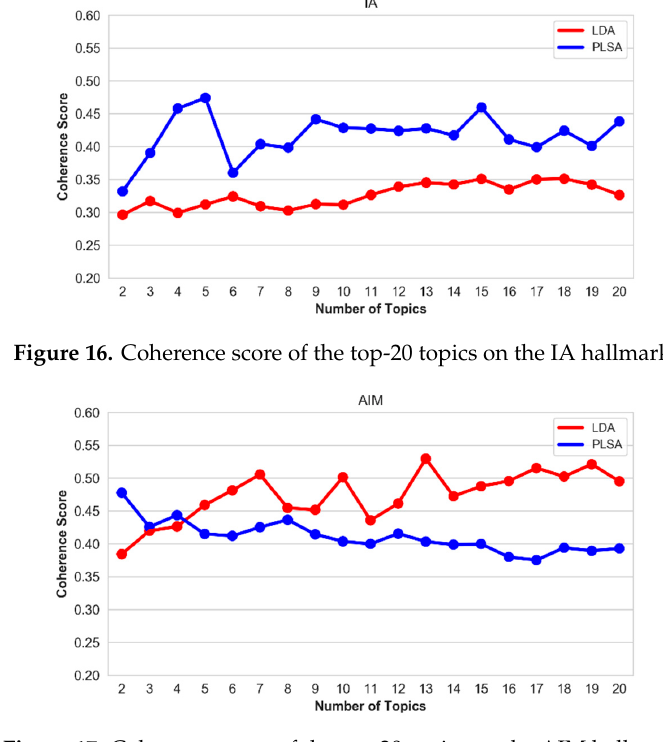
Figure 17. Coherence score of the top-20 topics on the AIM hallmark.